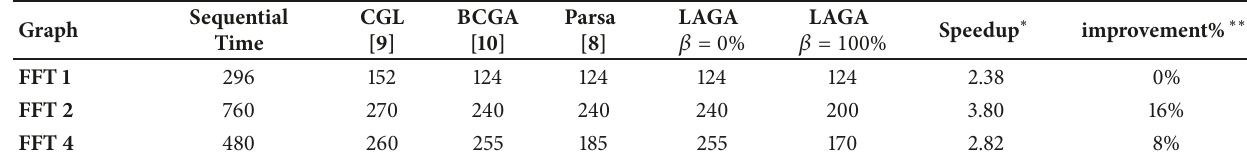
Table 5: Comparison of LAGA with well-known genetic-based algorithms on FFT benchmarks. Graph